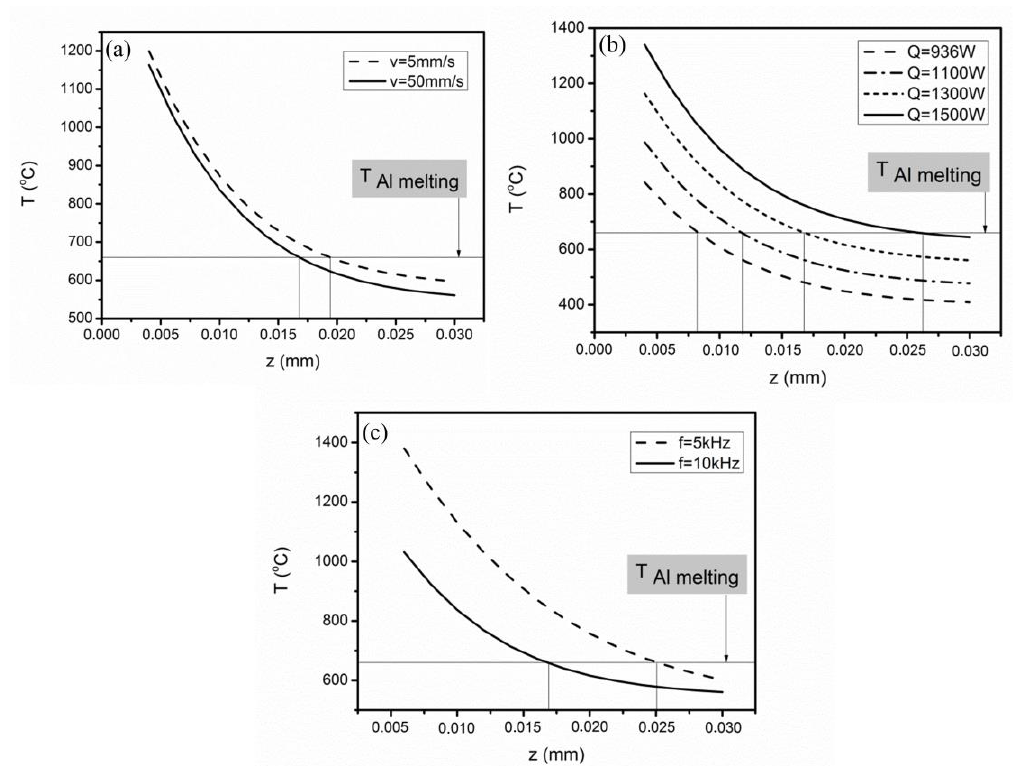
Figure 5. Distribution of the temperature along z axis for a ( a ) di ff erent velocities of specimen motion; ( b ) di ff erent electron-beam power; ( c ) di ff erent electron-beam scanning frequencies [18]. (Reproduced with permission from ref. [18]. Copyright (2019),